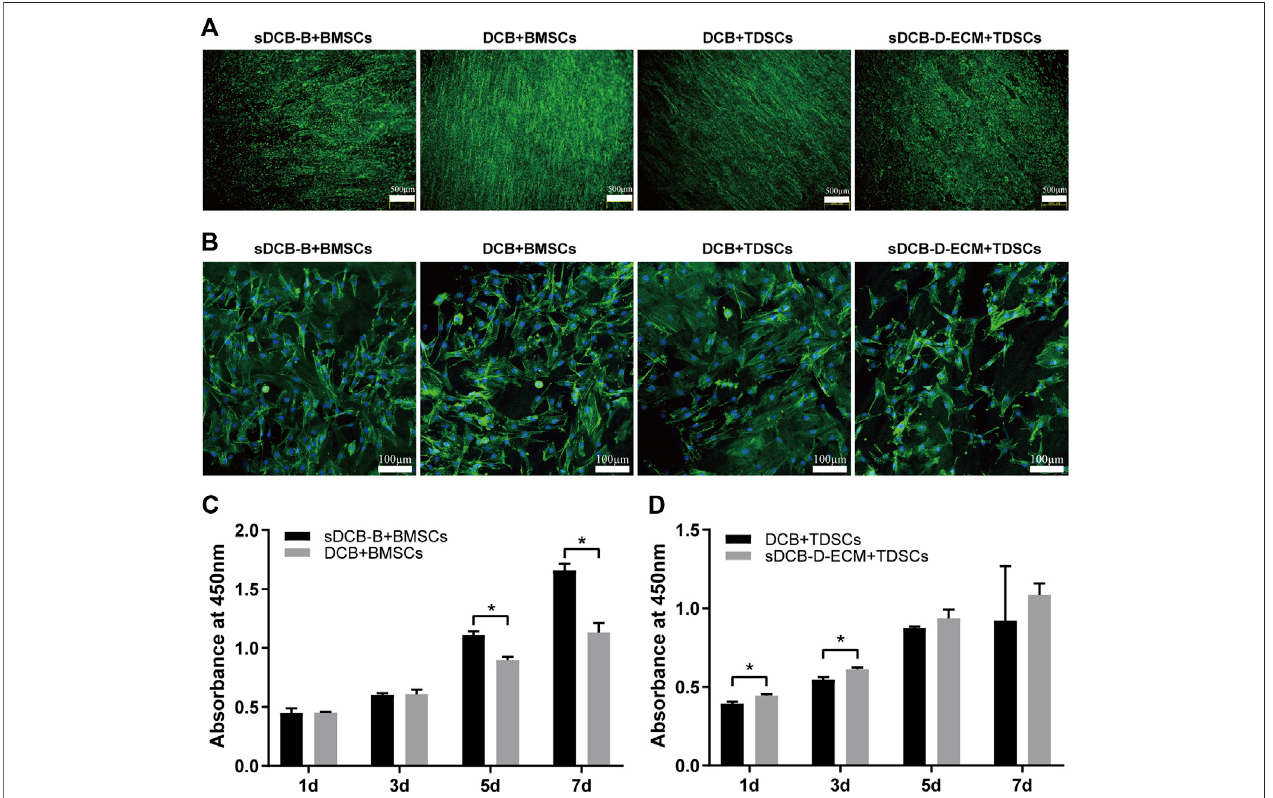
FIGURE 5 | The cell morphology and viability of BMSCs and TDSCs cultured on different scaffolds. (A) Live/Dead cell staining of BMSCs and TDSCs cultured on sDCB-B and sDCB-D-ECM. Scale bar (cid:1) 500 μ m. (B) The cytoskeleton staining of BMSCs and TDSCs cultured on scaffolds. Scale bar (cid:1) 100 μ m. (C) The cell proliferation analysis of BMSCs cultured on sDCB-B and DCB. * Indicated p < 0.05. (D) The cell proliferation analysis of TDSCs cultured on DCB and sDCB-D-ECM. * Indicated p < 0.05.